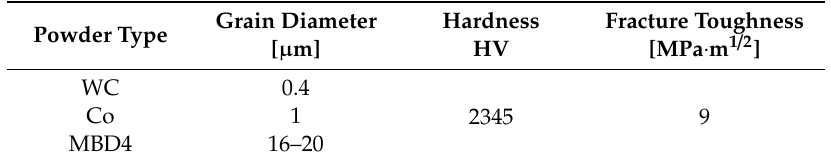
Table 1. Characteristics of powders and some mechanical properties of the uncoated Diamond Dispersed Cemented Carbide (DDCC) composite.